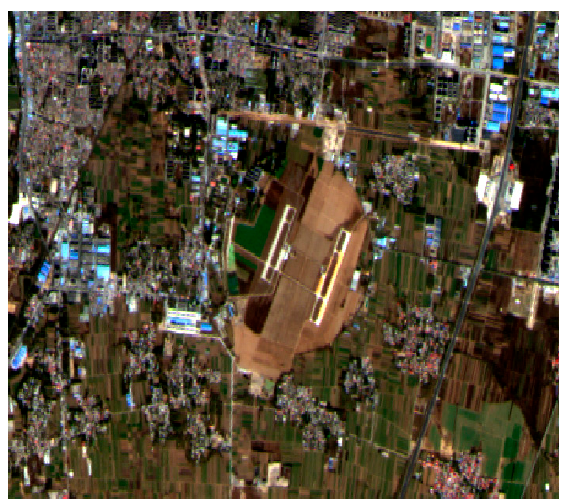
Figure 20. The airport that was not detected by both methods.